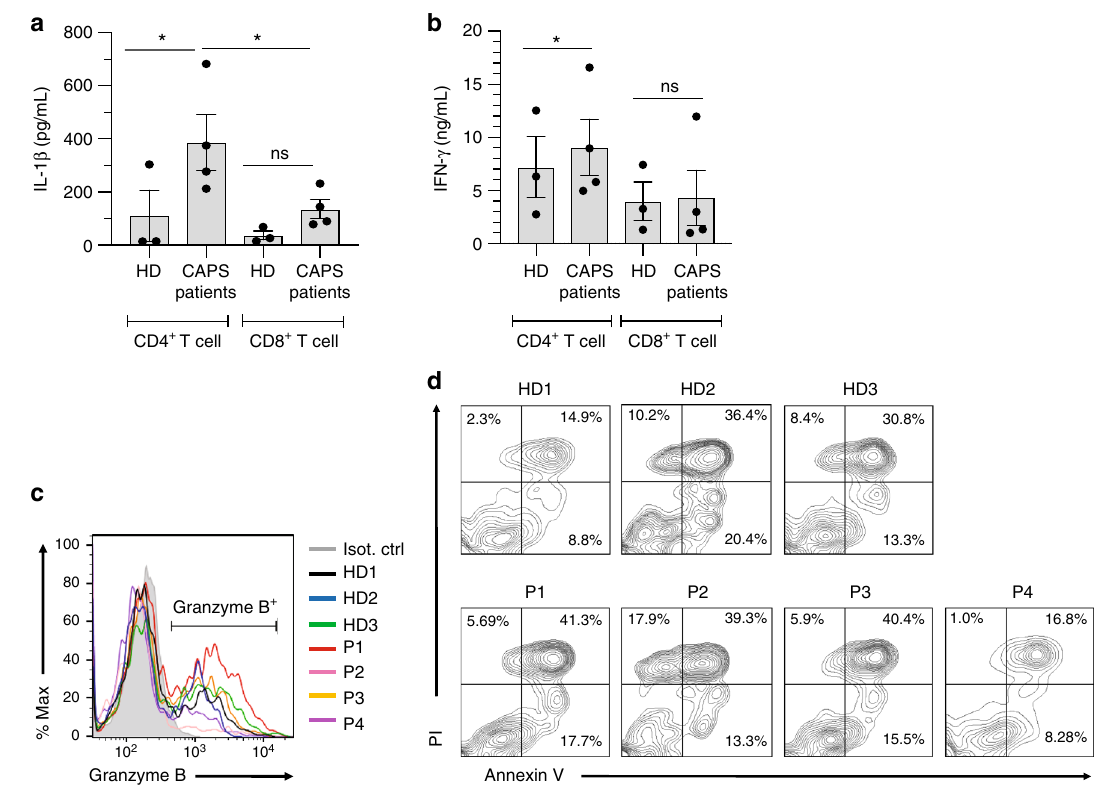
Fig. 5 CTLs from CAPS patients function normally. a , b IL-1 β and IFN- γ production upon CD46 co-stimulation in CD4 + and CD8 + T cells from CAPS patients. T cells from four CAPS patients and three age and sex-matched HDs were CD3 + CD46-activated and IL-1 β ( a ) and IFN- γ ( b ) secretion measured at 60 h post activation. c Granzyme B expression in CD3 + CD46-activated CD8 + T cells from CAPS patients at 60 h post activation (gating strategy shown in Supplementary Fig. 7b; gray histogram, Isotype control; black, blue, and green histogram, HD1 – 3, respectively; red, pink, yellow, and purple histogram, P1-P4, respectively). d Cytotoxic activity of CD8 + T cells from CAPS patients. CD8 + T cells from HDs 1 – 3 and CAPS patients 1 – 4 were CD3 + CD46-activated for 24 h and their cytotoxic activity determined (gating strategy in Supplementary Fig. 7c). Error bars denote mean ± SEM. * p < 0.05; ns, statistically not signi fi cant. Statistical analyses were performed using One-way ANOVA with Tukey Multiple Comparison